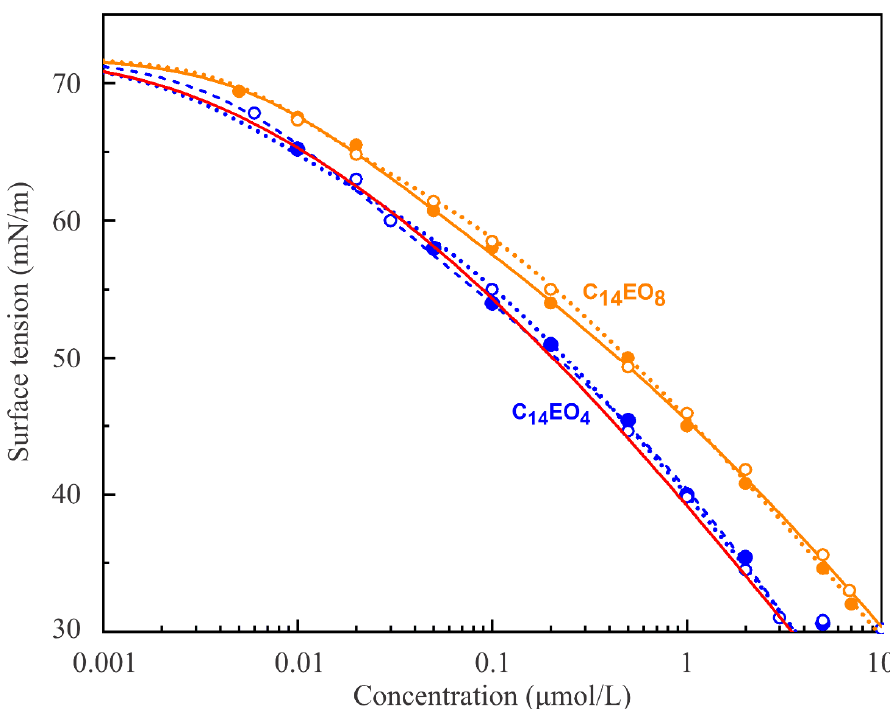
Figure 1. Experimental surface tension isotherms of С 14 ЕО 4 (blue symbols and curves) and С 14 ЕО 8 (yellow symbols and curves) surfactant solutions. Open symbols, [19]; filled symbols, this work. The respective theoretical isotherms are calculated for s = 2 (dotted curves), s = 5 (dashed curve), and s = 10 (solid curve) with the parameter sets presented in Tables 1 and 2. Red line, the С 14 ЕО 4 theoretical surface tension isotherm for Model R0 with s = 5 and parameters selected to obtain the best fit with the experimental values. For details see text. Table 1. Parameters of the isotherms of C 14 EO 4 solutions assuming 2, 3, and 5 states of the multi ‐ state adsorption Model R.